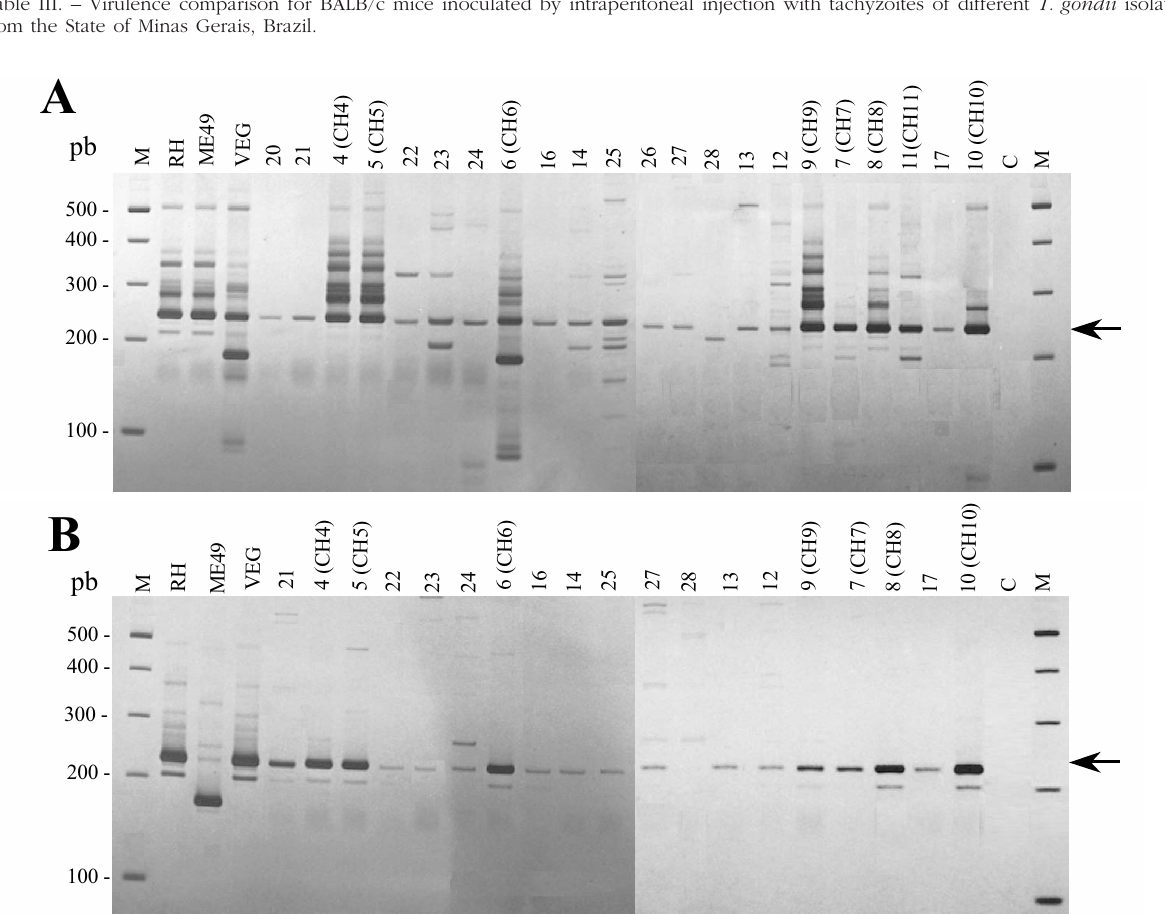
Table III. – Virulence comparison for BALB/c mice inoculated by intraperitoneal injection with tachyzoites of different T. gondii isolates from the State of Minas Gerais, Brazil.